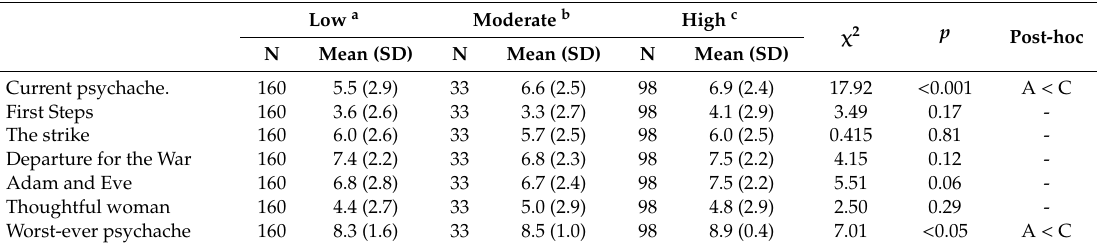
Table 3. Psychache by Suicide risk Kruskal-Wallis Rank Sum